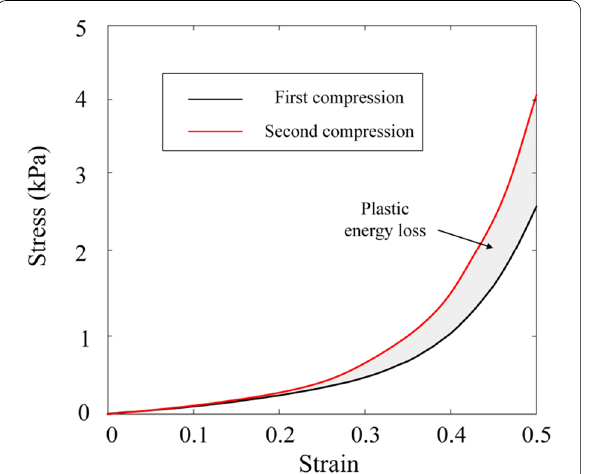
Figure 6 Soft tissue plastic deformation energy